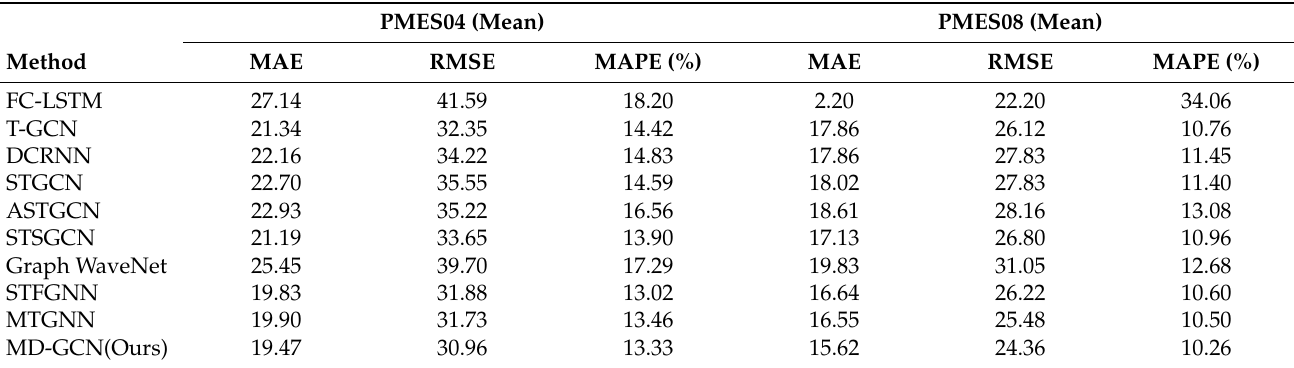
Table 5. The comparative results on PEMS04 and